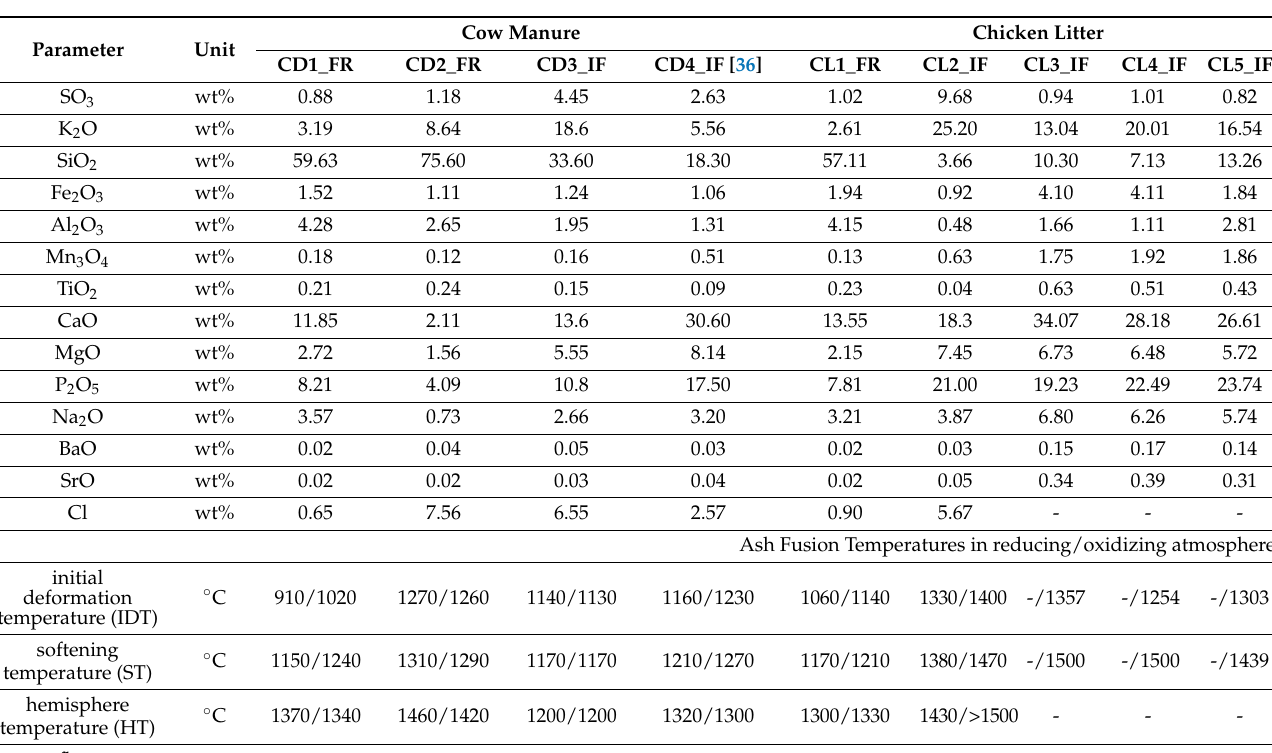
Table 2. Ash analysis (dry basis) and ash fusion